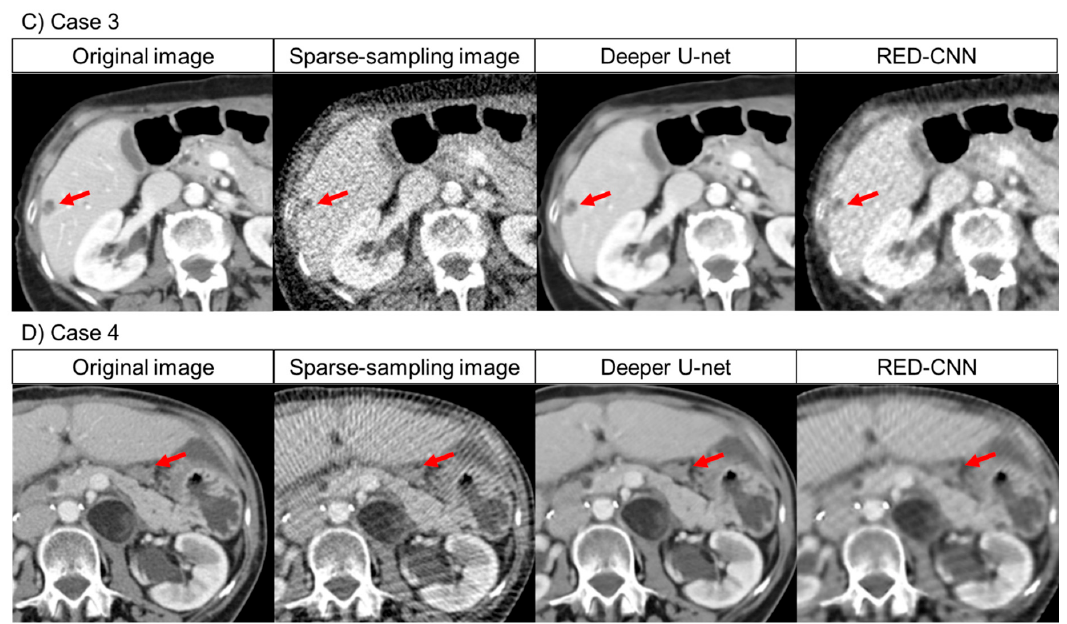
Figure 3. Representative images of the original CT, sparse-sampling CT before denoising, and denoised CT obtained using deeper U-net and RED-CNN. Note: ( A ) Case 1: Visual scores of peritoneal dissemination (white circle): 4 points for deeper U-net, 1 points for RED-CNN for reader 1; 4 points for deeper U-net, 1 points for RED-CNN for reader 2. ( B ) Case 2: Visual scores of lymph node metastasis (yellow arrow): 5 points for deeper U-net, 2 points for RED-CNN for reader 1; 4 points for deeper U-net, 2 points for RED-CNN for reader 2. ( C ) Case 3: Visual scores of liver metastasis (red arrow): 4 points for deeper U-net, 2 points for RED-CNN for reader 1; 4 points for deeper U-net, 2 points for RED-CNN for reader 2. ( D ) Case 4: Visual scores of peritoneal dissemination (red arrow): 4 points for deeper U-net, 2 points for RED-CNN for reader 1; 4 points for deeper U-net, 1 points for RED-CNN for reader 2.